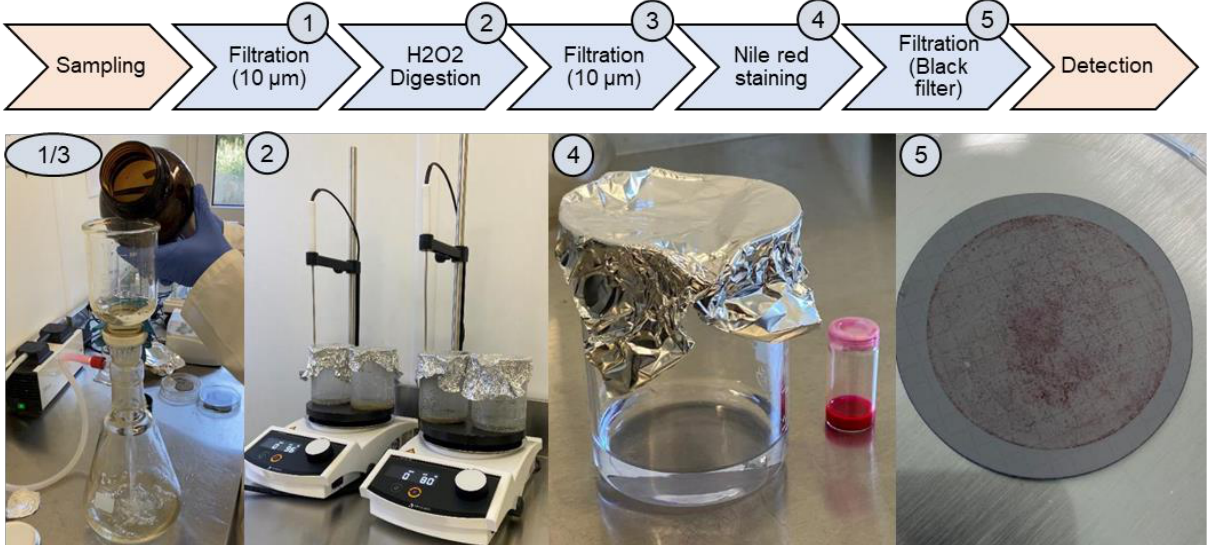
Figure 3. Scheme for the sample preparation procedure. The procedure consists of filtration steps (1/3), hydrogen peroxide digestion (2), Nile red staining (4) and a transfer of the stained sample to a black filter membrane